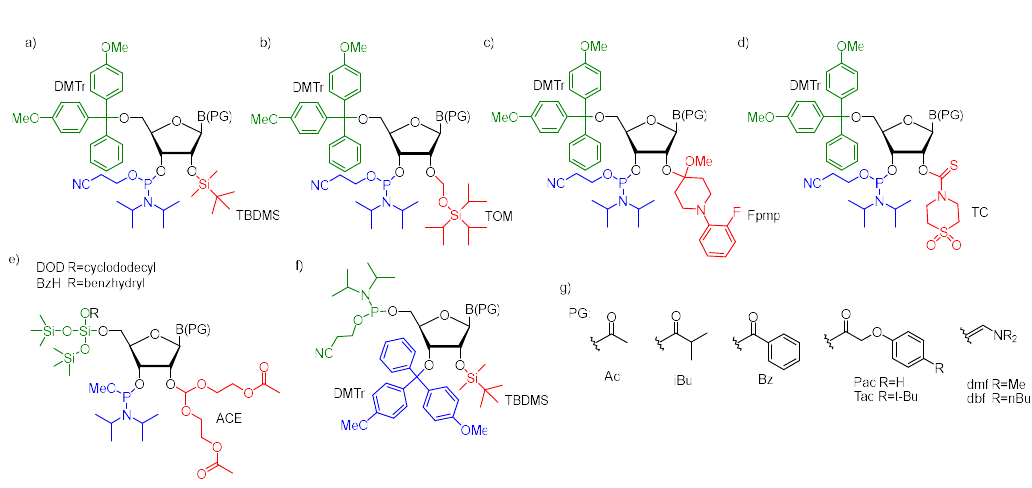
Figure 2. The most common ribonucleoside phosphoramidite building blocks for solid-phase RNA synthesis; ( a ) 5′- O -DMTr–2′- O -TBDMS–3′- O -(2-cyanoethyl- N,N -diisopropylphosphoramidite); ( b ) 5′-